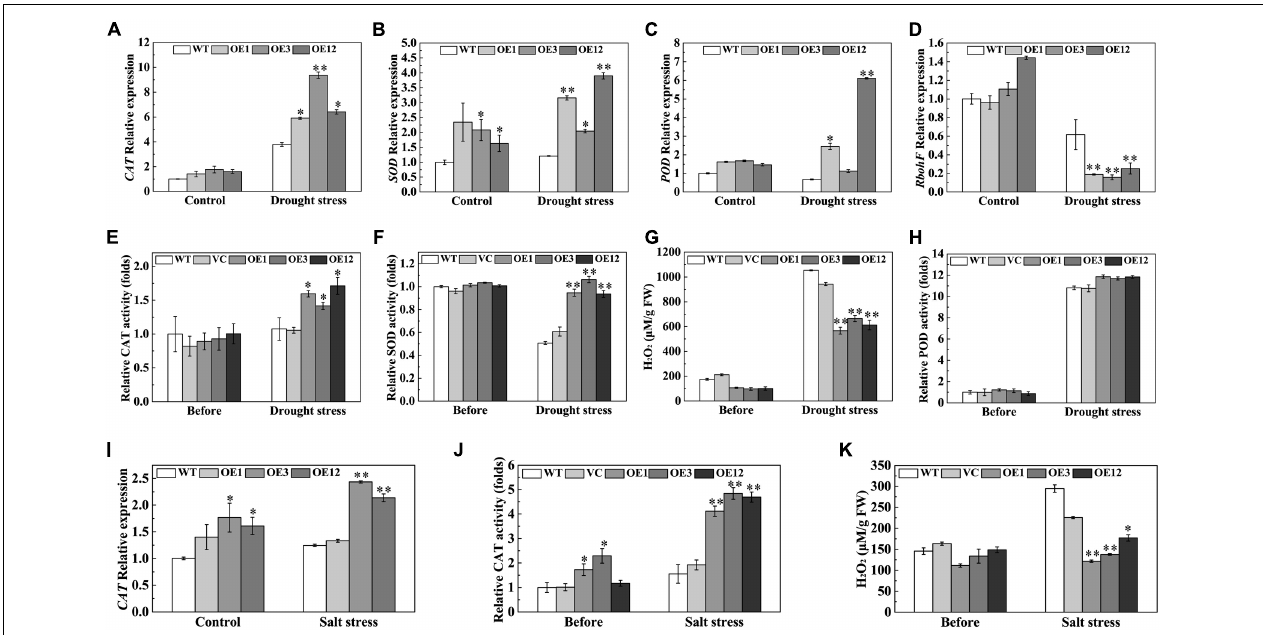
FIGURE 8 | Overexpression of TaODORANT1 in tobacco elevated antioxidant enzymes gene expression and activities under drought/salt stress. (A–D) Expression levels of CAT , SOD , POD, and RbohF in tobacco seedlings after 300 mM mannitol treatment for 7 days. (E–H) H 2 O 2 content and activities of CAT, SOD, and POD in plant leaves after drought treatment. (I) Expression levels of CAT in tobacco seedlings after 150 mM NaCl treatment for 7 days. (J,K) CAT activity and H 2 O 2 content in plant leaves after NaCl treatment. Three independent biological replicates were performed and produced similar results. Vertical bars refer to ± SE ( n = 3). Asterisks indicate significant difference between the WT and the transgenic lines ( ∗ P < 0.05; ∗∗ P < 0.01).